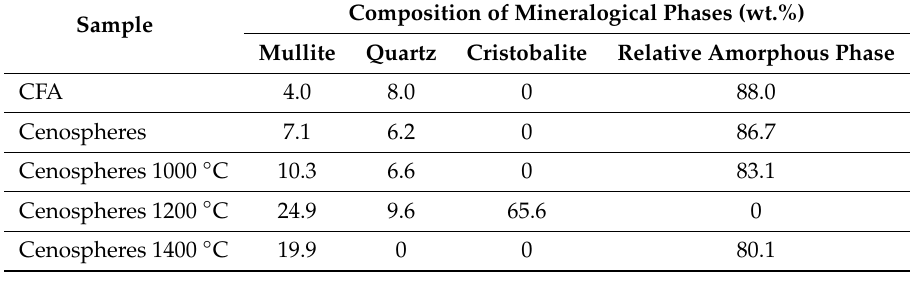
Table 2. Mineralogical phase composition of CFA and cenosphere samples.